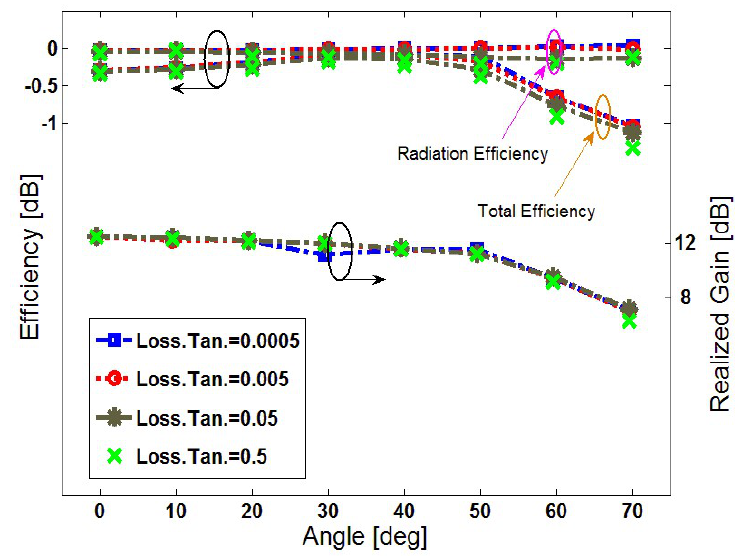
Figure 18. Efficiencies and gain results for different loss tangents (δ) at 22.25 GHz for different scanning angles.